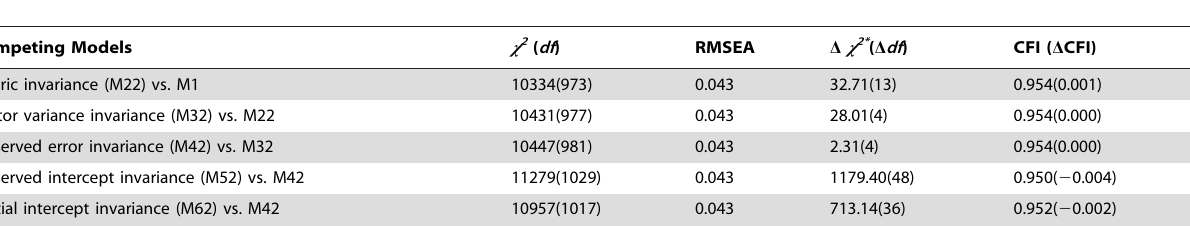
Table 6. Longitudinal measurement invariance tests of demand-control-support factor model across 2008 & 2012.